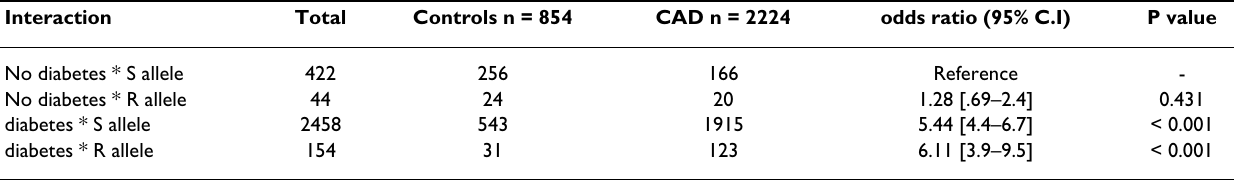
Table 2: Interaction of diabetes mellitus and E-selectin polymorphism in coronary artery disease Interaction Total